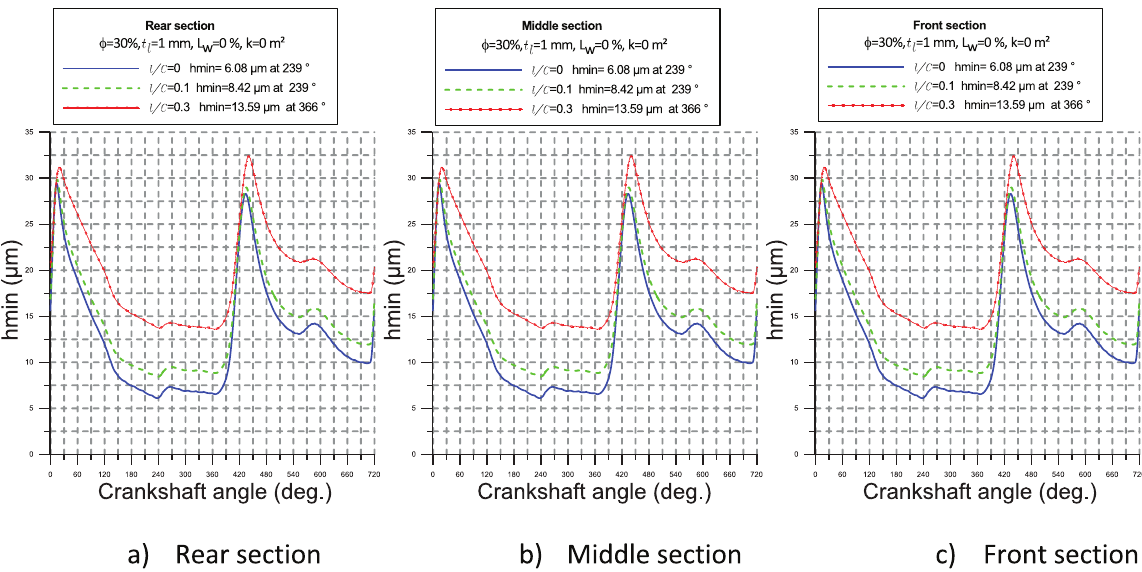
Fig. 16. Effects of the particle size parameter, l / C , on the minimum fi lm thickness over an engine cycle for the deformable